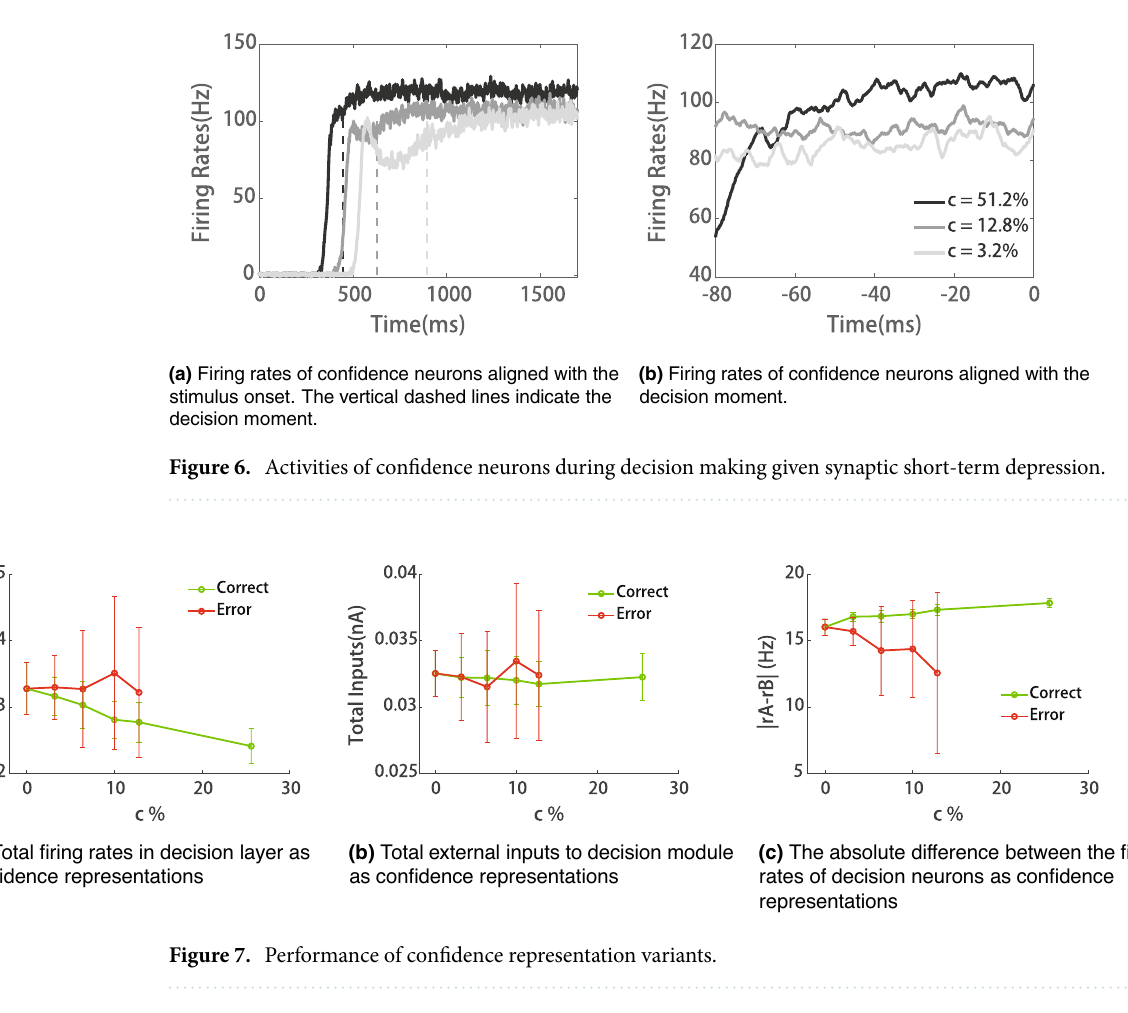
(a) Total firing rates in decision layer as confidence representations